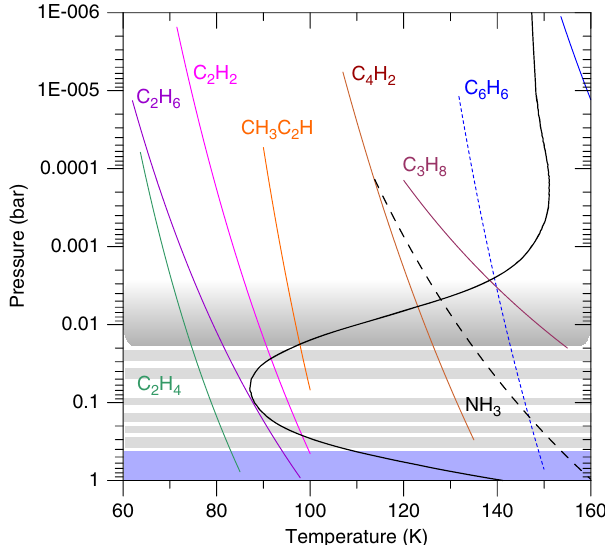
Fig. 4 Vertical temperature pro fi le and saturation vapor-pressure curves for different hydrocarbons. The reference altitudes used for the assumed hydrocarbon mole fractions are given as follows (Supplementary Fig. 6): C 3 H 8 (10 − 7 at P = 3 mbar); C 4 H 2 (3.8 × 10 − 12 at P = 3 mbar); CH 3 C 2 H (7 × 10 − 11 at P = 3 mbar); C 2 H 2 (4.8 × 10 − 8 at P = 3 mbar); C 2 H 6 (4.5 × 10 − 6 at − 10 at P = 3 mbar). For C P = 3 mbar); C 2 H 4 (3 × 10 6 H 6 , two values of the mole fraction are considered at two altitudes, with the corresponding saturation curves represented by two lines: blue continuous (mole fraction 7.7 × 10 − 12 at P = 3 mbar, from ref. 33 ) and blue dashed (mole fraction 2.6 ×1 0 − 10 at P = 0.1 mbar from Supplementary Fig. 6). Condensation and haze base formation occur at altitudes where the saturation vapor-pressure curves intersect with the temperature pro fi le. The location of the observed haze layers is indicated by horizontal gray